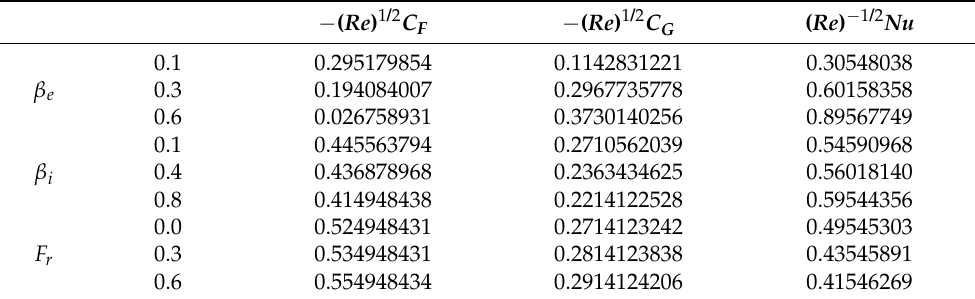
Table 4. Numerical values of coefficients related to skin friction coefficients and the Nusselt number against variations in β e , β i and F r by inserting tri-hybrid nanoparticles when m = 0.1, We = 2, Ω = 2.0, M 2 = 0.5, (cid:101) = 0.03, Pr = 204, Ec = 0.7, ϕ 2 = 0.0075, ϕ 1 = 0.002, ϕ 3 =